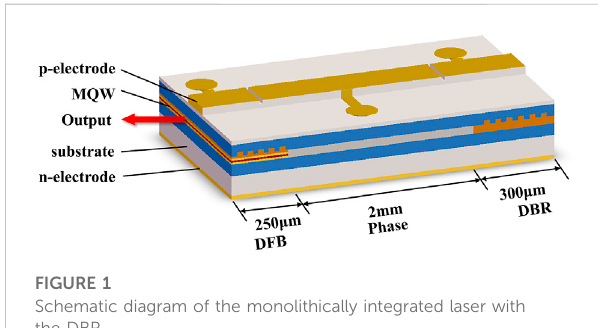
FIGURE 1 Schematic diagram of the monolithically integrated laser with the DBR.